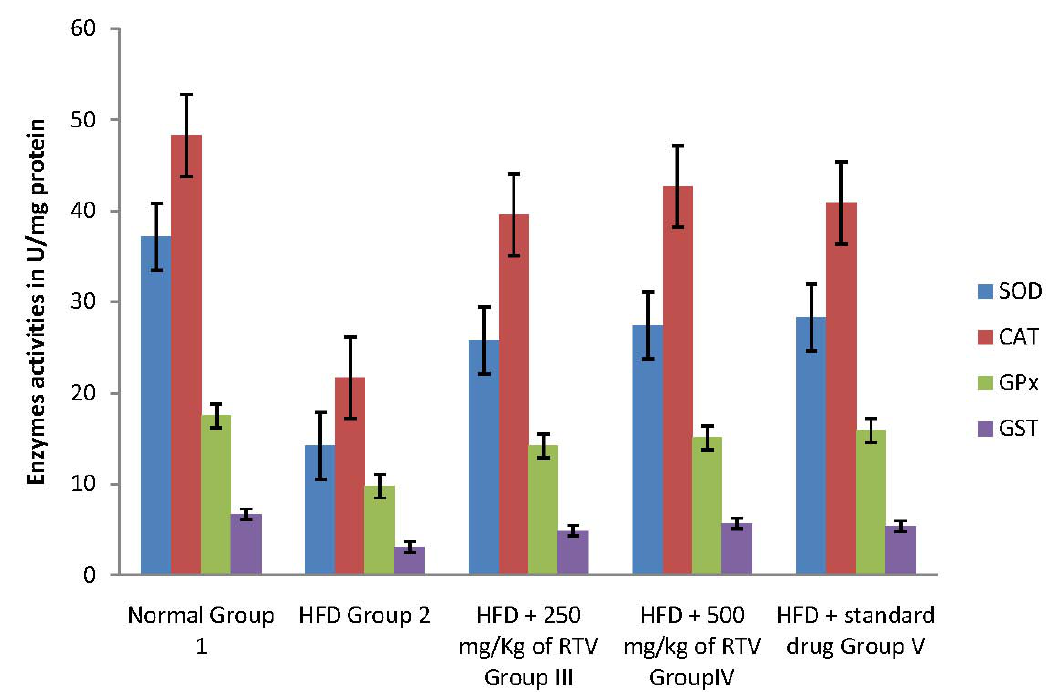
Figure 3. Effects of methanolic extract of rhizomes of T. violacea treatment on antioxidants defense viz., Superoxide dismutase (SOD), catalase (CAT), glutathione peroxidase (GPx) and glutathione-S-transferase (GST) in high fat diet induced oxidative stress in rats heart